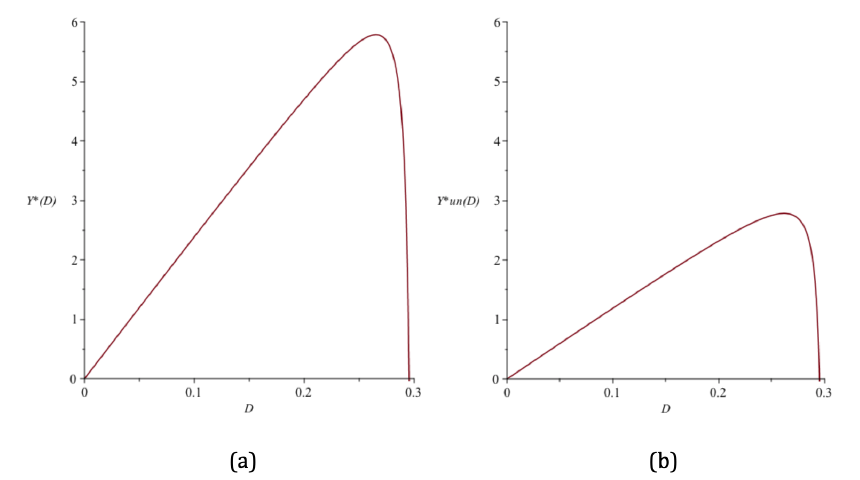
Figure 7. ( a ) Yield Y ∗ ( D ) at equilibrium for the system of coupled chemostats with respect to D . ( b ) Yield Y ∗ un ( D ) at equilibrium for each uncoupled chemostat. Parameters set: µ = 0.3 h − 1 ,